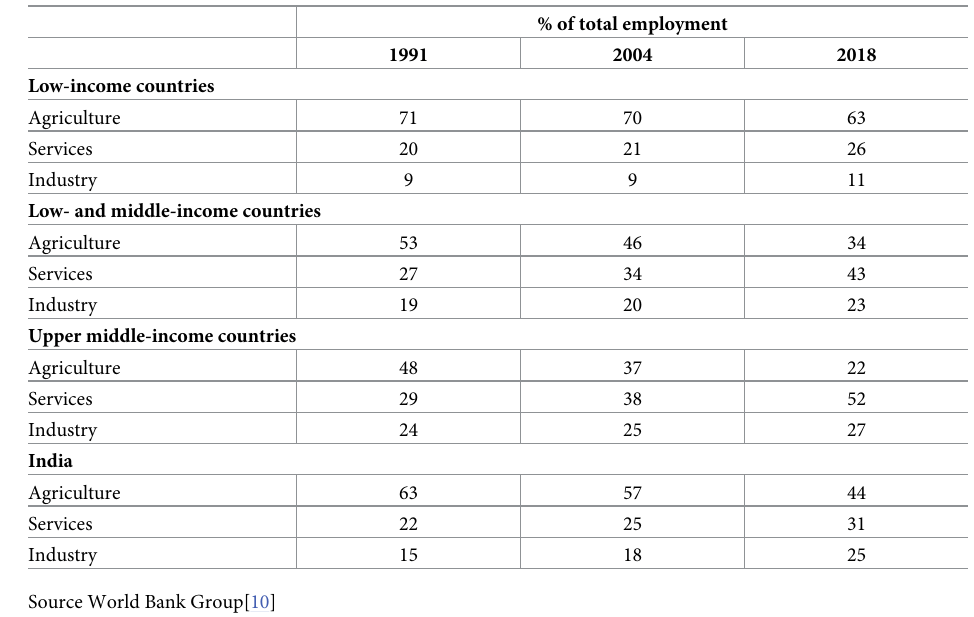
Table 1. Percent employment in agriculture, services and industry of total employment in low-and middle- income countries.